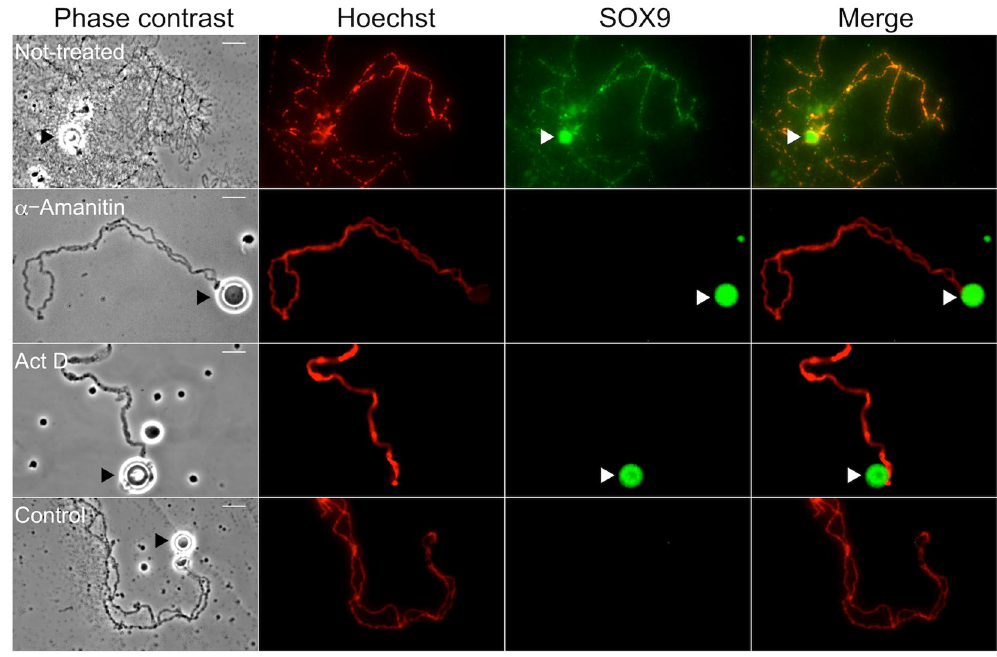
Figure 5. Immunostaining of SOX9 after inhibition of transcription. Oocytes of P. waltl were treated or not with α -Amanitin or Actinomycin D (Act D). Phase contrast and corresponding fluorescent micrographs of nuclear spreads that were stained with the anti-Cter SOX9 antibody (green, Alexa 488 IgG) and counterstained with Hoechst (red) to show the chromosome axis. In contrast to the LBCs from the not-treated oocytes, those from the oocytes incubated with α -amanitin or Act D were devoid of their lateral loops and and the chromosome axis lacked SOX9 staining. Note that the spheres (arrowheads) known to be storage sites for transcription and post-transcription factors were strongly stained. The intensity of fluorescence in the different experiments was normalized with respect to their relevant controls with the secondary antibodies alone. Wide field Leica microscope. Scale bar for all micrographs: 15 μ m.